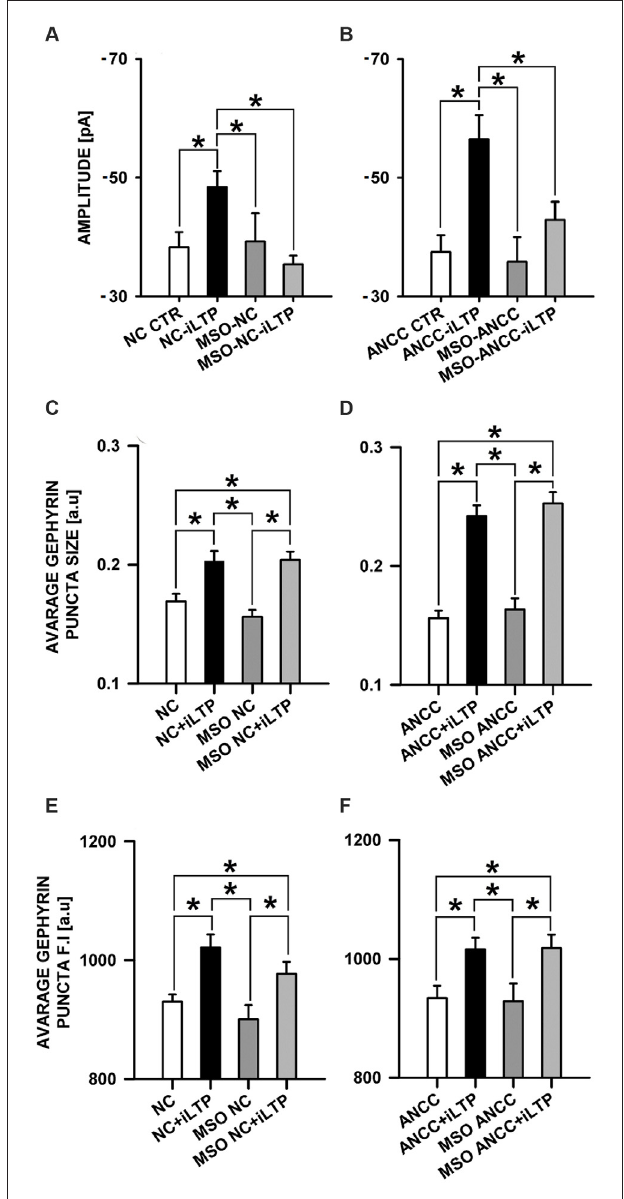
FIGURE 8 | Impact of inhibition of glutamine synthetase by MSO. MSO treatment prior to NMDA influence mISPC amplitude changes in both NC and ANCC without inducing morphological changes. (A) Average mIPSC amplitude in NC, (B) average mIPSC amplitude in ANCC, (C) average gephyrin puncta size in NC, (D) average gephyrin puncta size in ANCC, (E) average gephyrin puncta fluorescence intensity in NC, (F) average gephyrin puncta fluorescence intensity in ANCC. Control group (white bar), NMDA stimulated group (black bar), group treated with MSO (dark gray), group treated with MSO prior to iLTP induction group (gray bar). Star mark represent statistical significant data ( p < 0.05).